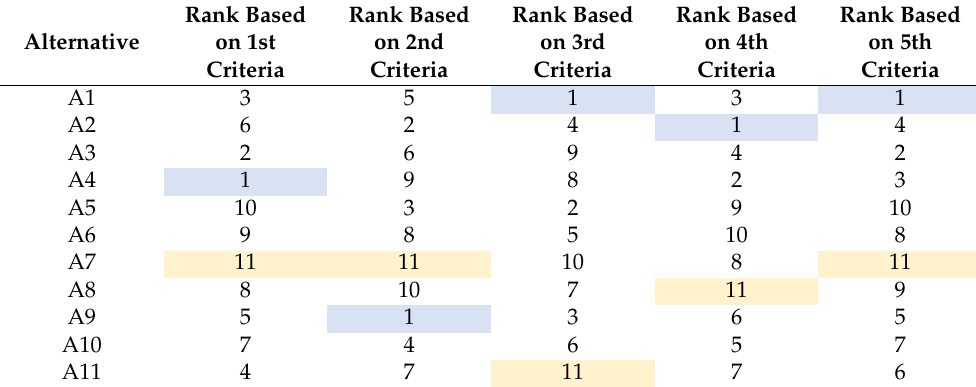
Table 14. Ranking comparison of all criteria.